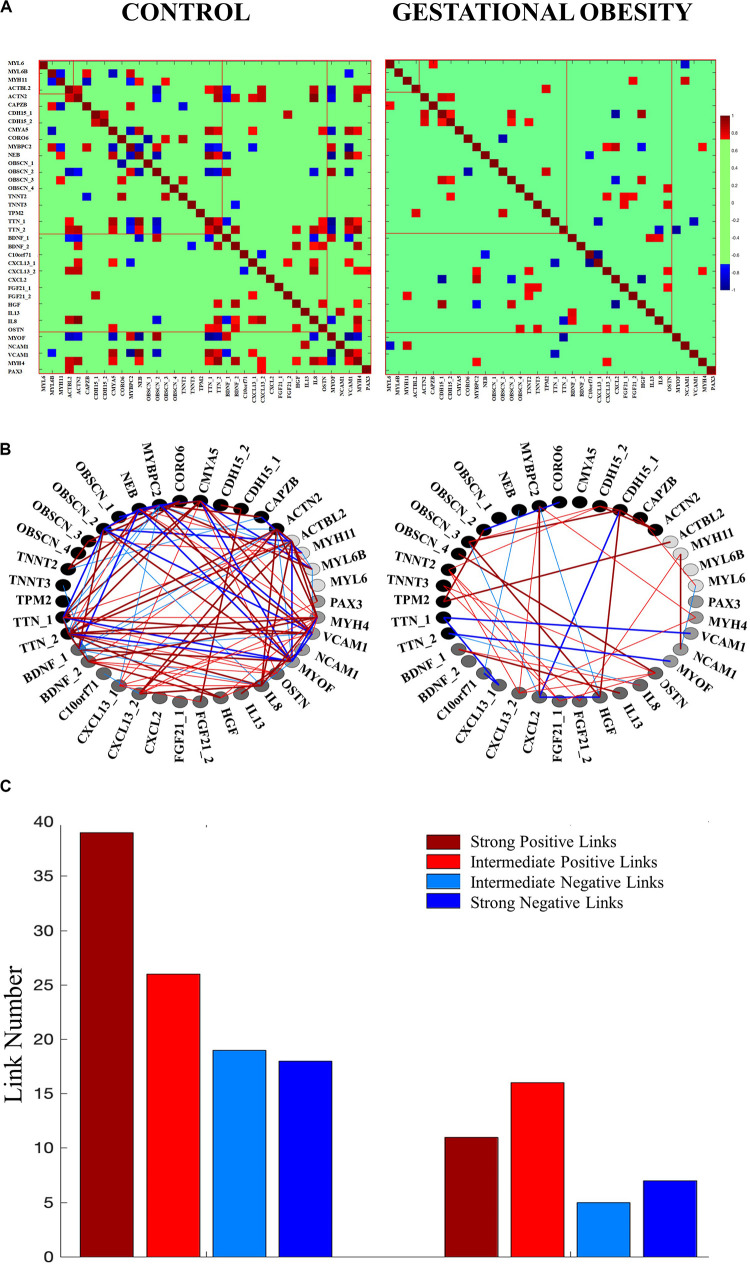
Co-methylation network interactions changes among the studied genes according to control and gestational obesity groups. (A) Gene co-methylation matrix. The matrices show the Pearson correlation coefficient of the methylation levels between every pair of genes. Non-significant correlations are represented in green. (B) Gene co-methylation networks. Each node represents a specific CpG for each studied gene category [contractibility (black), structure (dark gray), myokines (gray) and myogenesis (light gray)]. Links between two nodes represent the coupling strength (i.e., the Pearson coefficient) between two genes. The links are divided into four types: strong positive links (Pearson coefficients > 0.8; thick dark red lines), intermediate positive links (0.7 < Pearson coefficients < 0.8; thin red lines), intermediate negative links (−0.7 > Pearson coefficients >−0.8; thin blue lines), and strong negative links (Pearson coefficients <-0.8; thick dark blue lines). Note that the network only includes the significant correlations found in the co-methylation matrix. (C) Total number of links. The height of the bar corresponds to the number of significant correlations in the co-methylation matrix.